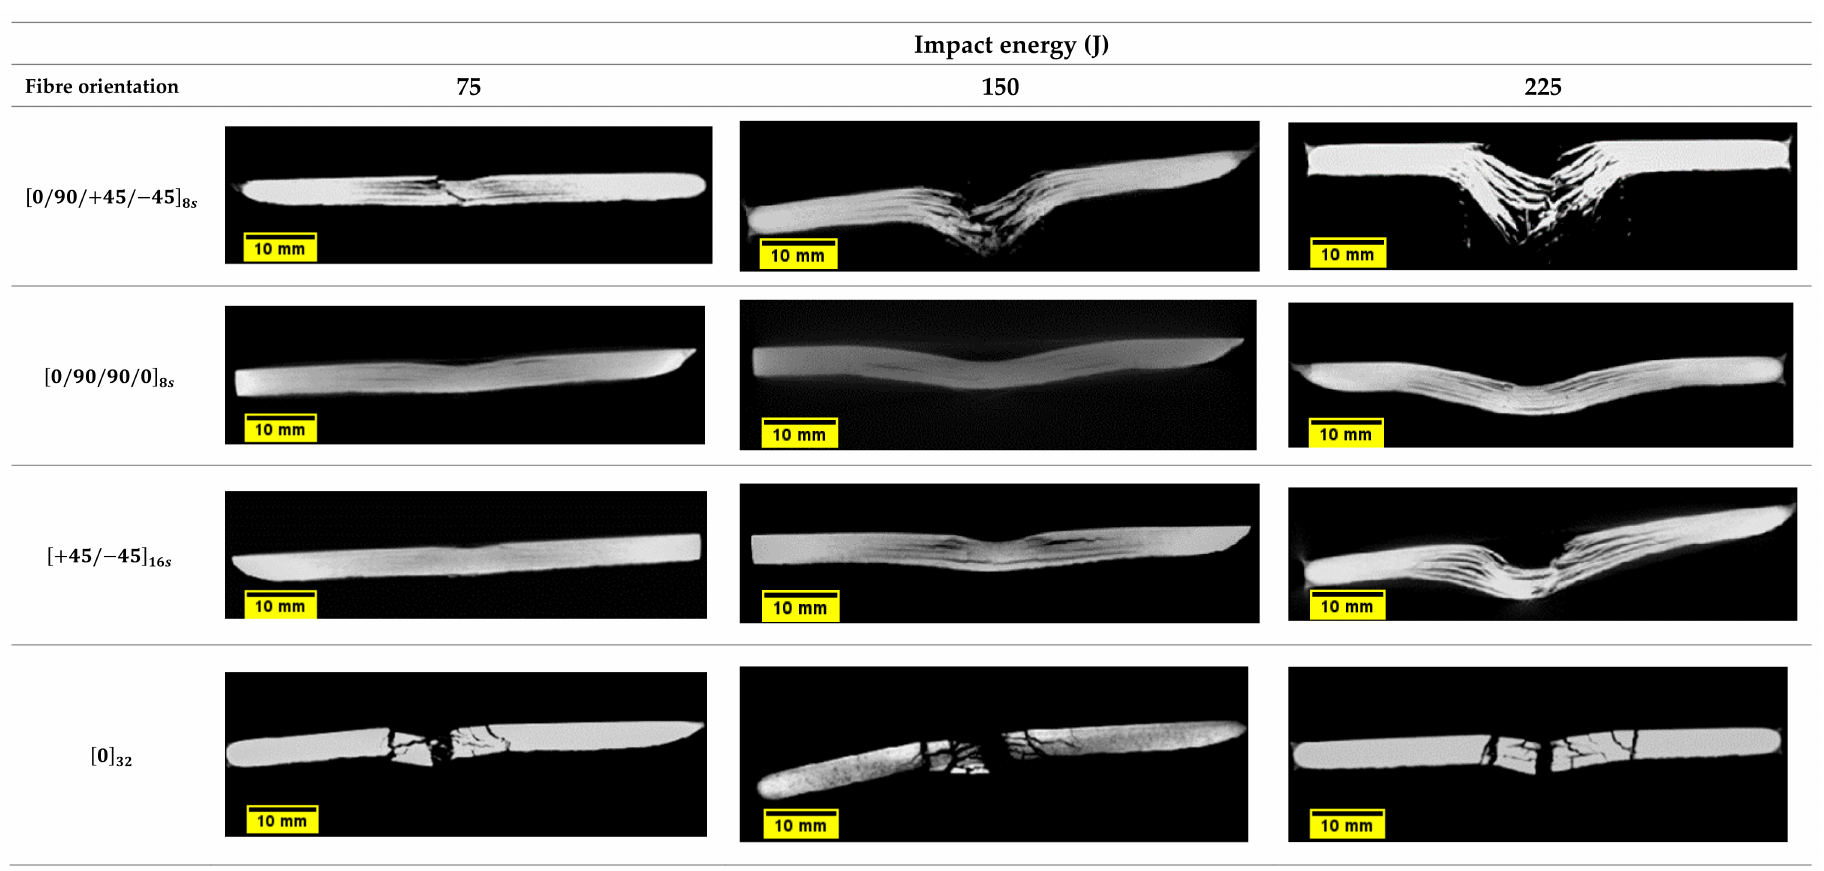
Figure 12. Cross-sectional micrographs of the S2/glass fibre plates impacted at different energy